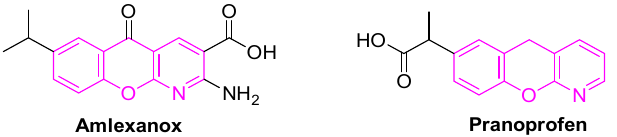
Figure 1. Bioactive chromeno[2,3- b ]pyridines.